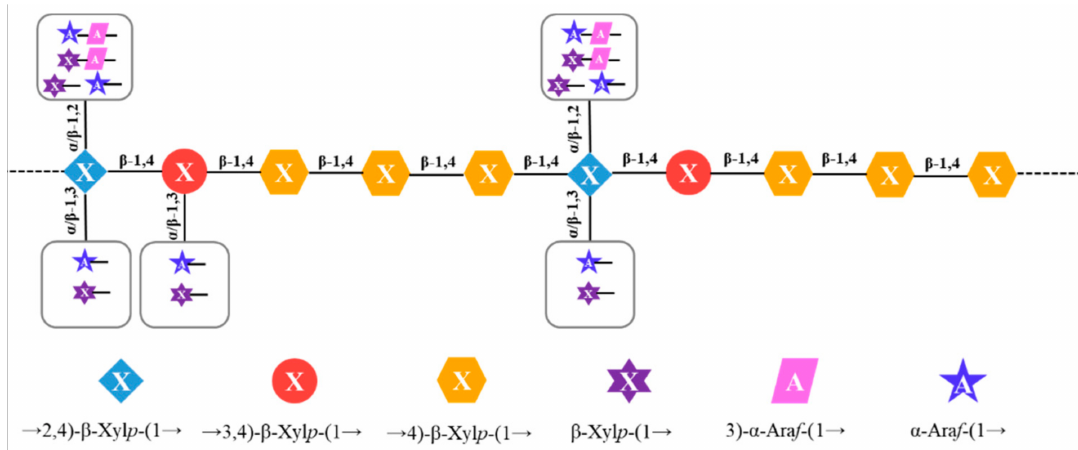
Figure 3. The proposed core units of arabinoxylan from